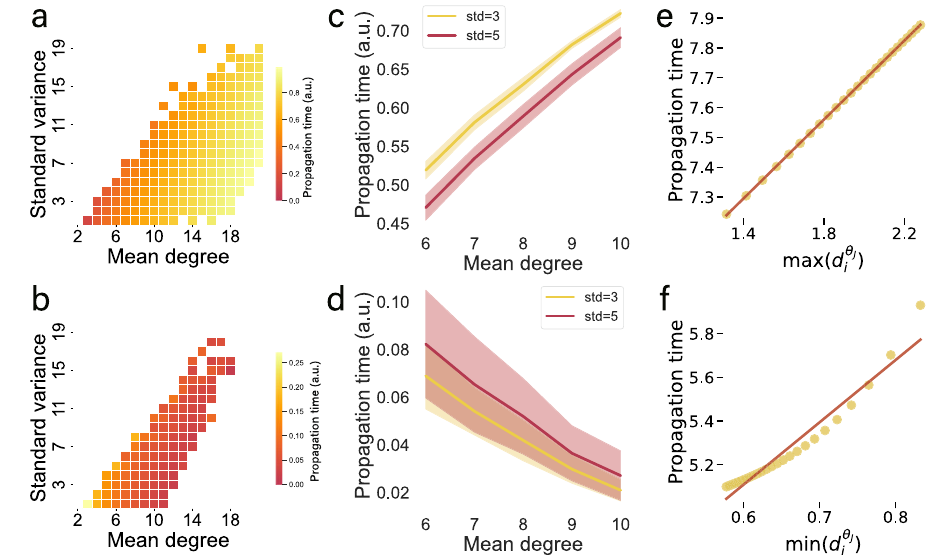
θ − 0.17<0( f ).Thelinearrelationship(red fi ttingline)indicatethatthesimulated J = response time is well described by max ð d θ J i Þ or min ð d θ J i Þ . a – f Regulatory dynamics,